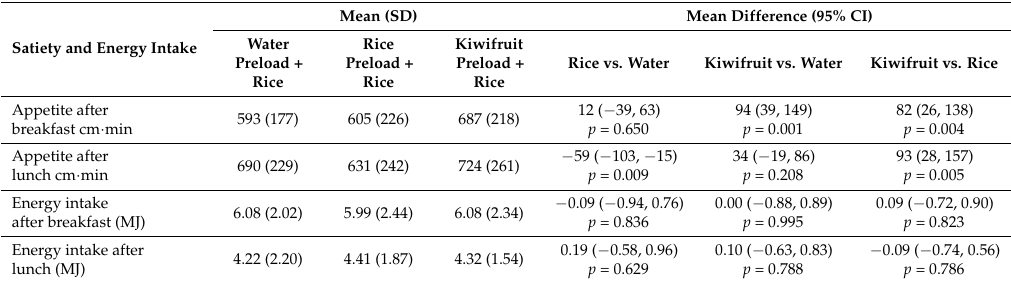
Table 4. Appetite responses via visual analogue scales, and subsequent energy intake following treatments (note: the breakfast and the lunch tests were on different